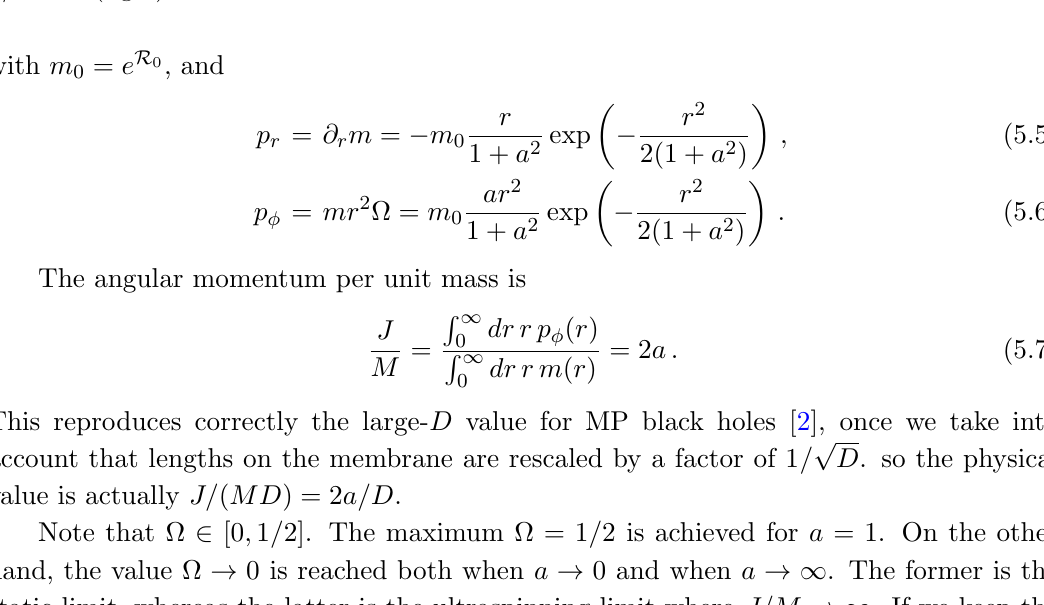
Figure 2 . Mass density pro(cid:12)les m ( r ) for black holes with J=M = 0 (left), J=M = 1 (middle), J=M = 2